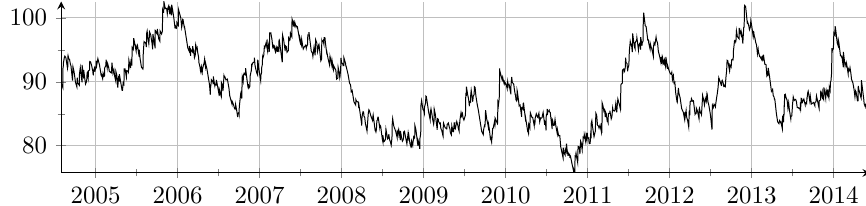
Figure 2. Moving average of wavelengths over N chart, where the y -axis shows the mean number of candles between two maxima (and also between two